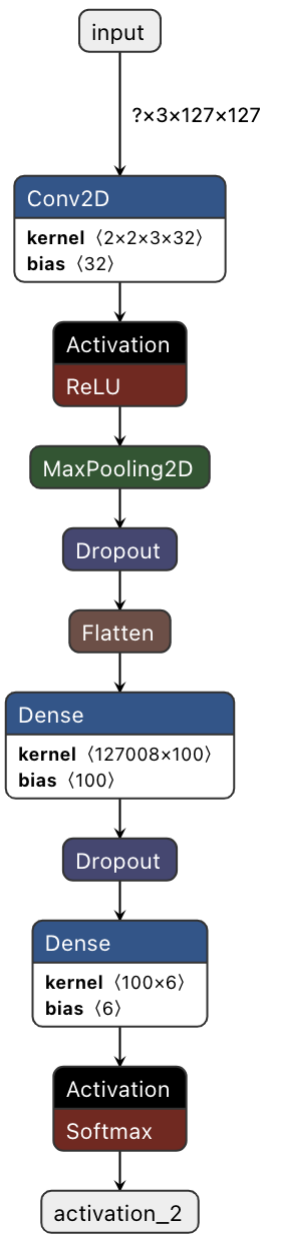
Figure 3. Architecture of Plant Identification